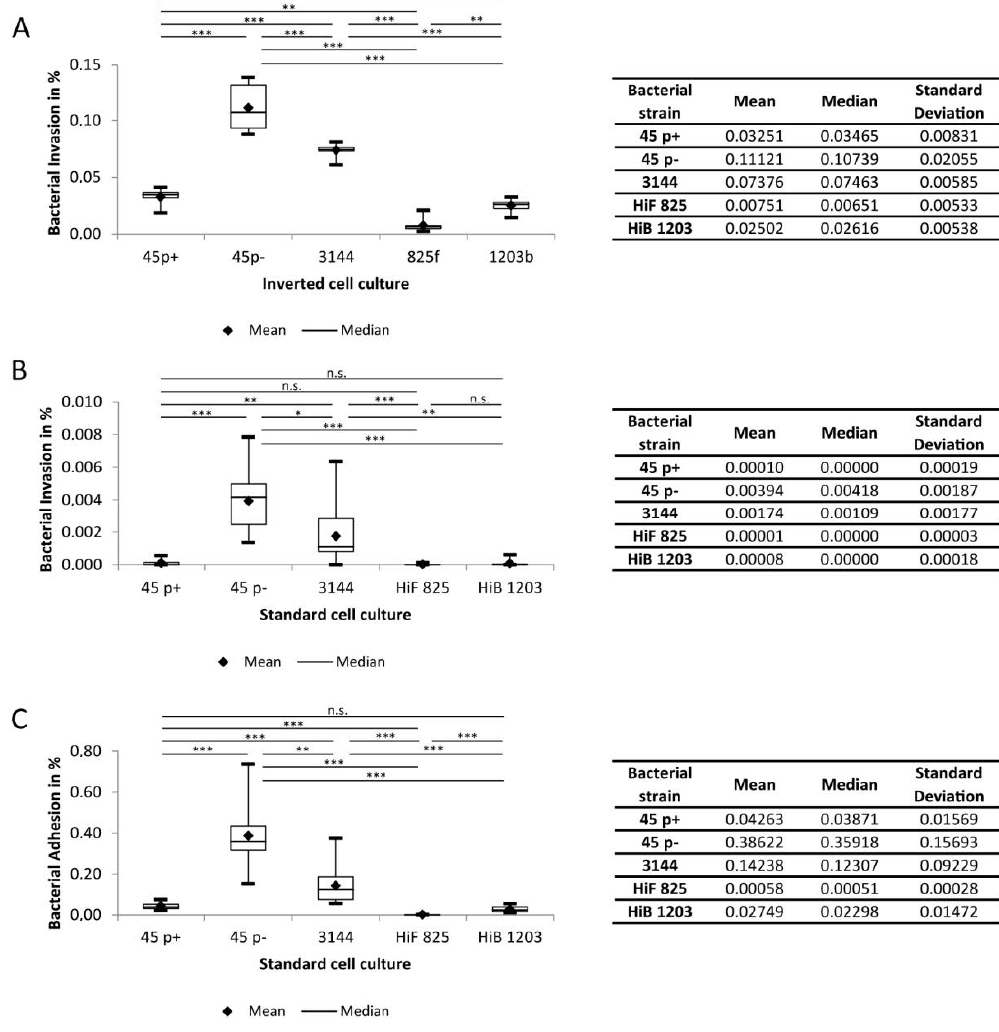
Figure 7. Invasion and Adhesion rates of indicated H. influenzae strains. Invasion upon infection with a MOI of 20 was counted after 6 h of infection: ( A ) invasion rates in the inverted cell culture ( n = 9); ( B ) invasion rates in the standard cell culture (( n = 12, n = 13 for HiF 825); and ( C ) adhesion rates in the standard cell culture. Each experiment was repeated at least three times with at least three replicates. All data are shown as mean and median together with quartiles, minimum and maximum. The box depicts the interquartile range (25% and 75%). * p < 0.05; ** p < 0.01; *** p < 0.001; n.s., not significant.